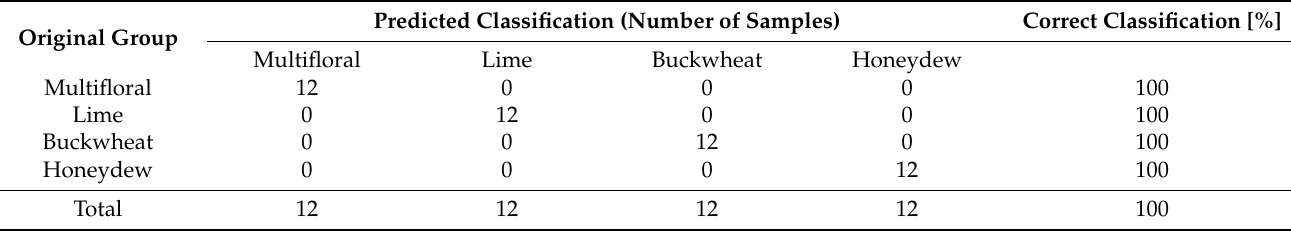
Table 5. Classification results of the analyzed honeys using the LDA. Original